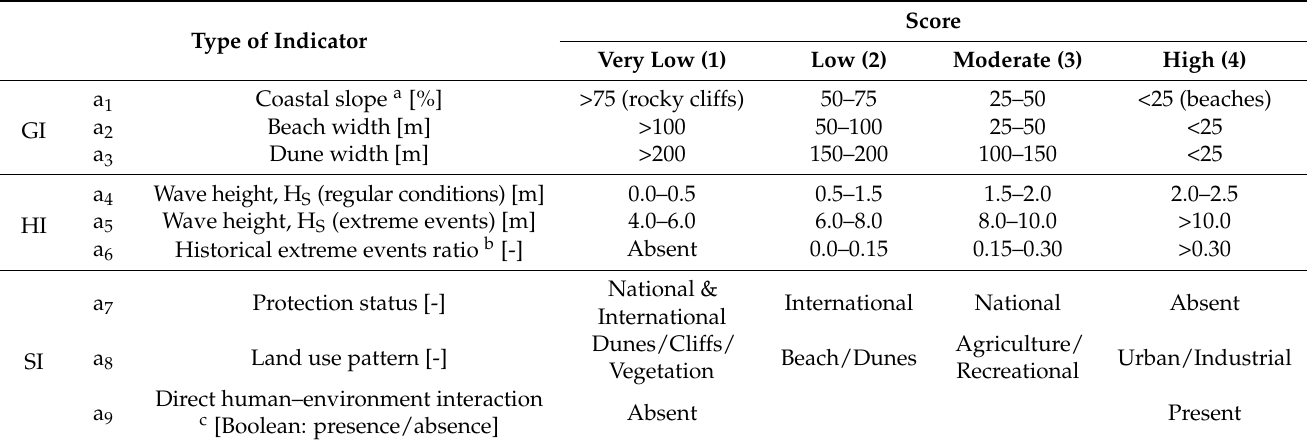
Table 2. Ranges of vulnerability for the CVI indicators (a i